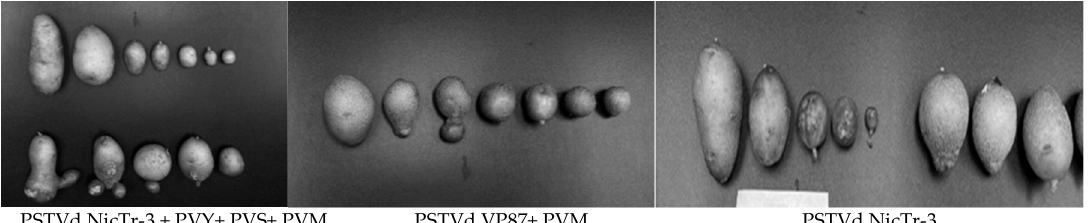
Figure 11. Tubers of cv. Navigator at 90 dpi with PSTVd and viral/viroid mixed infection.